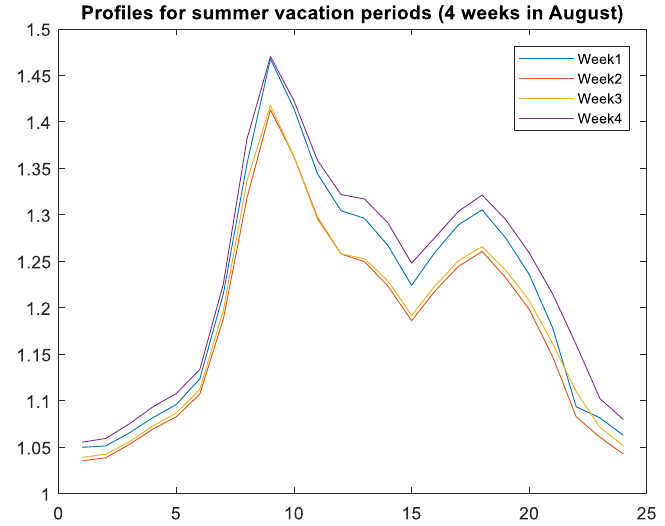
Figure 18. Coefficient profiles for days within the summer vacation period. Central weeks in August experience a lower demand than weeks 1 and 4.